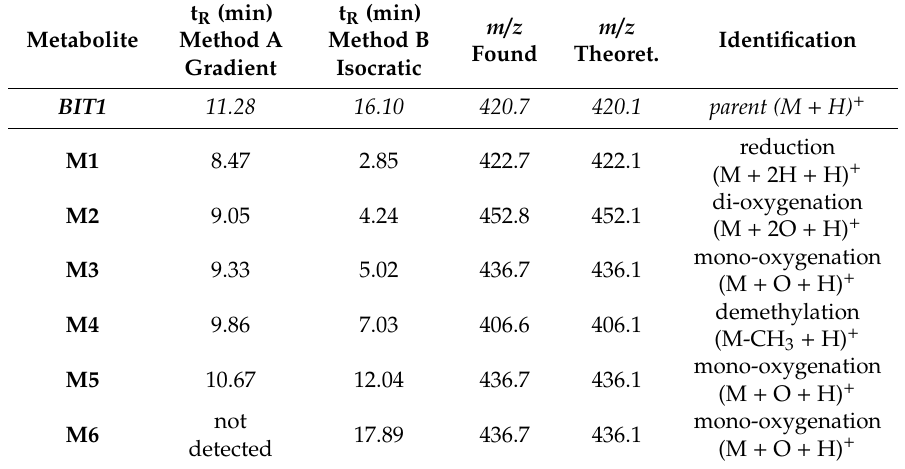
Figure 3. HPLC-UV chromatogram after incubation of BIT1 with MLM in the presence of NADPH (for conditions, see the experimental part): ( a ) UV chromatogram (partial) recorded during gradient elution (Method A); ( b ) UV chromatogram recorded during isocratic elution (Method B). Table 6. Overview of HPLC and MS data of in vitro metabolites of BIT1 formed by MLM in the presence of NADPH.